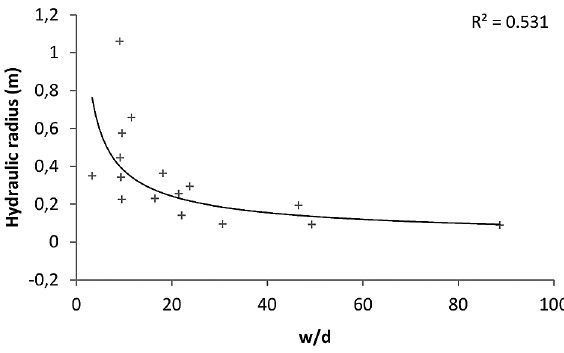
Fig. 7. Higher the Width-depth Ratio lower is the Hydraulic Radius.